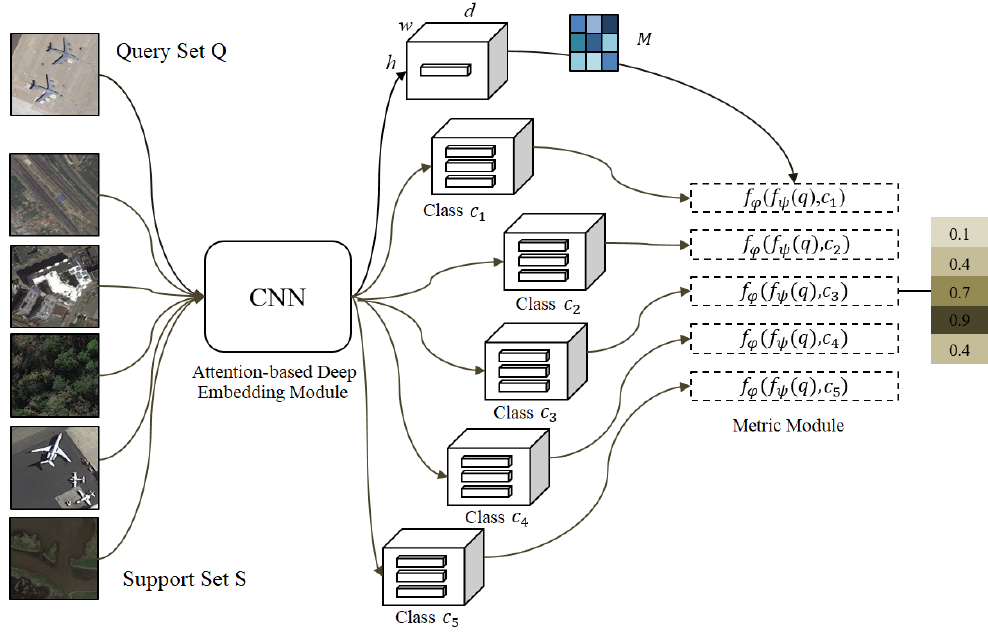
Figure 3. The architecture of